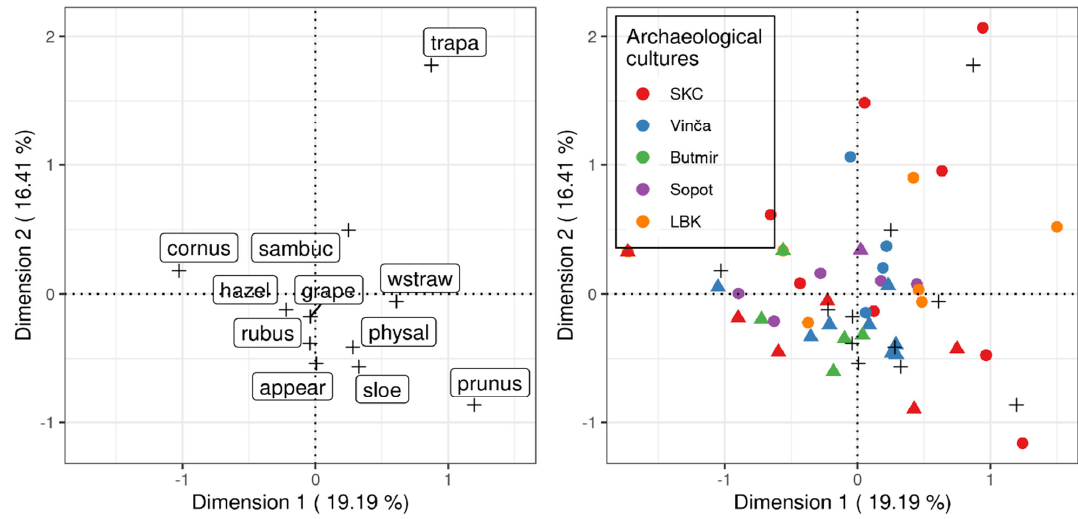
Figure 9. Correspondence analysis plots of wild taxa and sites (triangles denote Pannonian sites; circles denote Continental sites. See Table 1 for full taxa